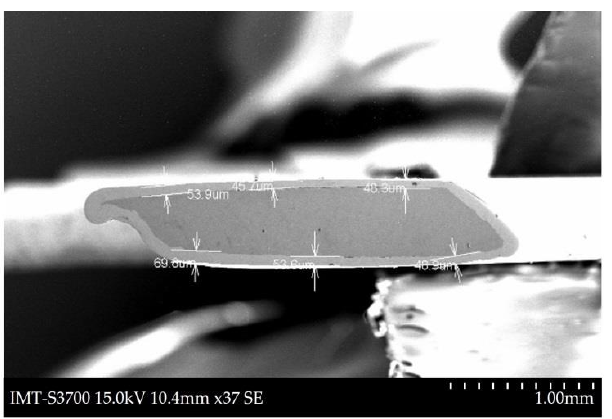
Figure 1. Micrograph of the NiCoB/CS coating thickness obtained from scanning electron microscope (SEM) of a transverse cut sample.